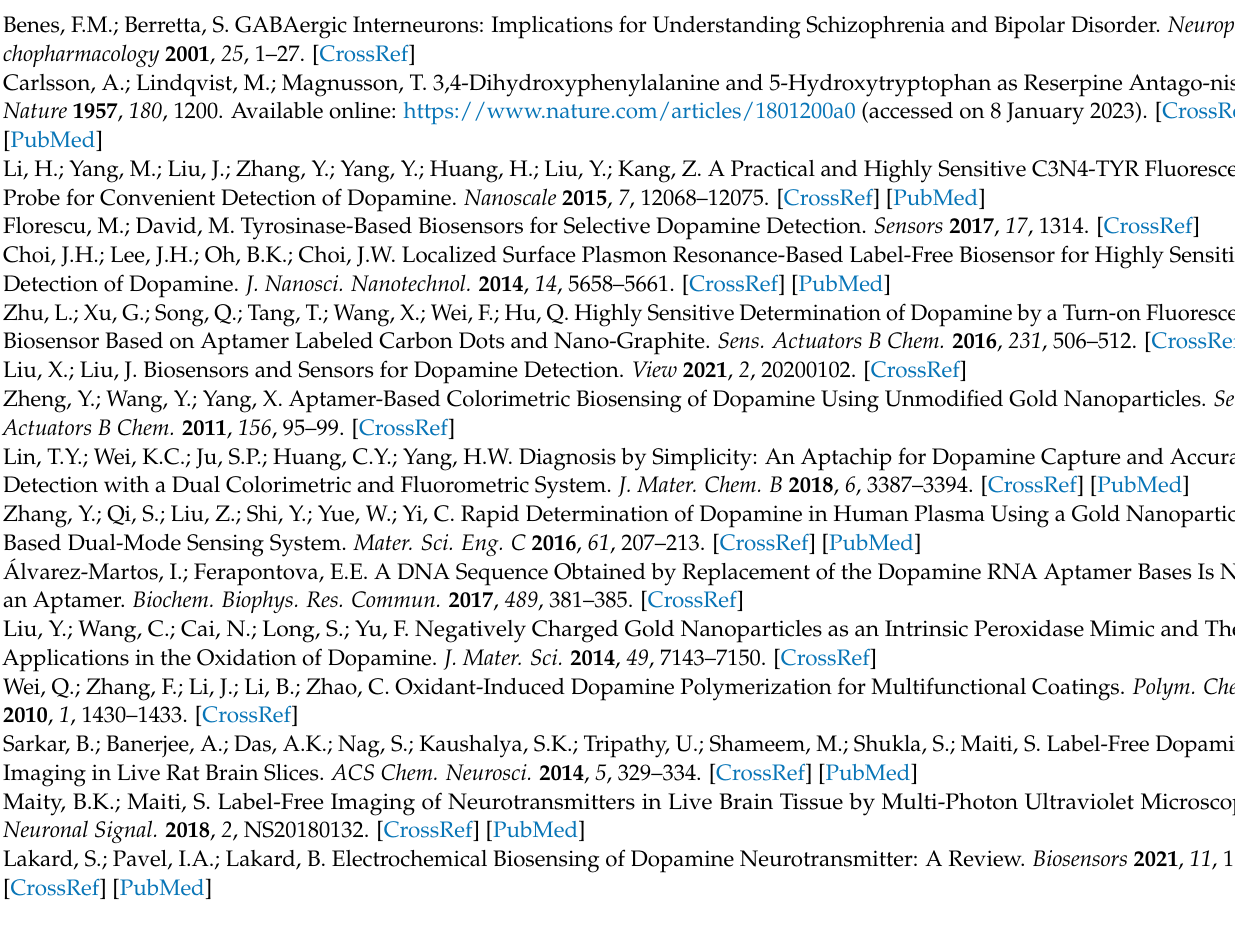
from 8–18 µ M DA. Figure S13: DPV plot of 1 µ M AA in PBS (7.4 pH). Figure S14 (a): CV plot for the interference of anions, (b–e) DPV plot for the interference of anions. Figure S15: Interference DPV plot of DA, L-Cyst & GA. Figure S16: Interference DPV plot of DA in Ca2+, K+ &Na+. Figure S17: Interference plot in FBS medium for 6 µ M DA in presence of AA, amino acids, cations, and anions. Figure S18 (a): Current VS. potential CV plot of 5 µ M DA (7.4 pH) in 20 cycles for stability studies, (b) Current Vs. cycle plot of I2-CMP-CNT-4 modified GCE in 20 cycles. Figure S19: Peak reproducibility DPV plot of 5 µ M DA (7.4 pH) in 8 days, and Current Vs. day plot and RSD value. Figure S20: Peak reproducibility DPV plot of 6 µ M DA (7.4 pH) in 8 days, and current Vs. day plot and RSD value. Figure S21: CV plot for the electrochemical behavior of CNT-modified GCE towards DA. Figure S22: Stability study of I2-CMP-CNT-4 (1 µ M DA) at various time duration in PBS (7.4 pH). Figure S23: C(1s) deconvolution spectra of